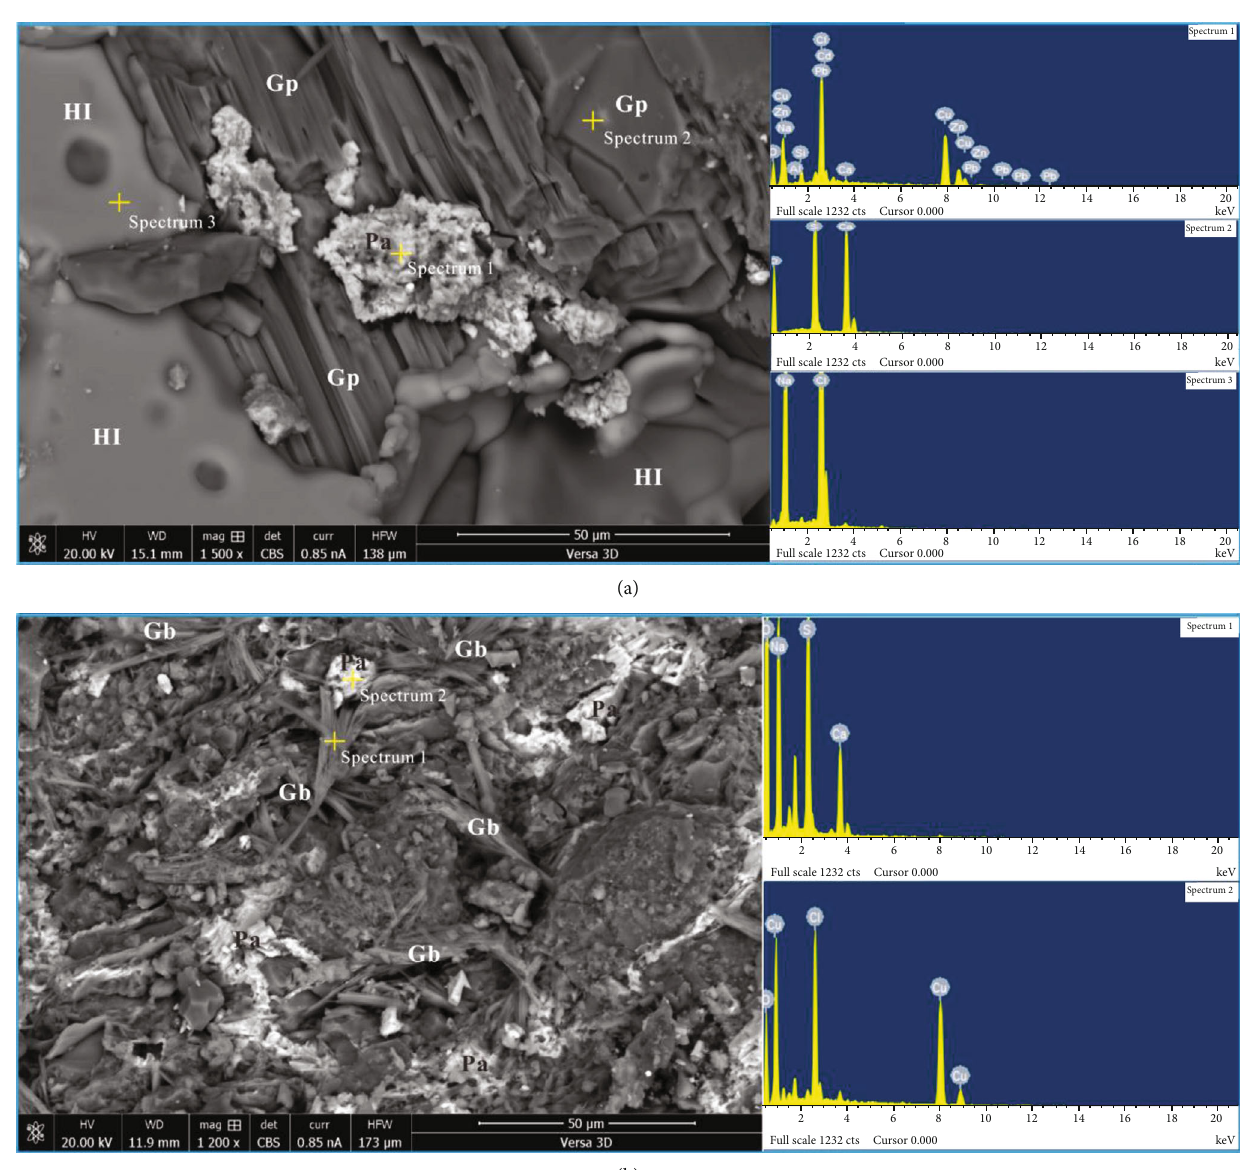
Figure 3: SEM and EDS analysis of sample KC-G paratacamite; Gp: gypsum; Gb: glauberite; HI: halite. (a) Left: SEM image; right: EDS graph. The white mineral, containing mainly Cu, Cl, O, and a few Si, Al, Ca, Pb, and Zn, is paratacamite (Cu containing Ca, S, and O is gypsum (CaSO EDS graph. The radial material is glauberite (Na